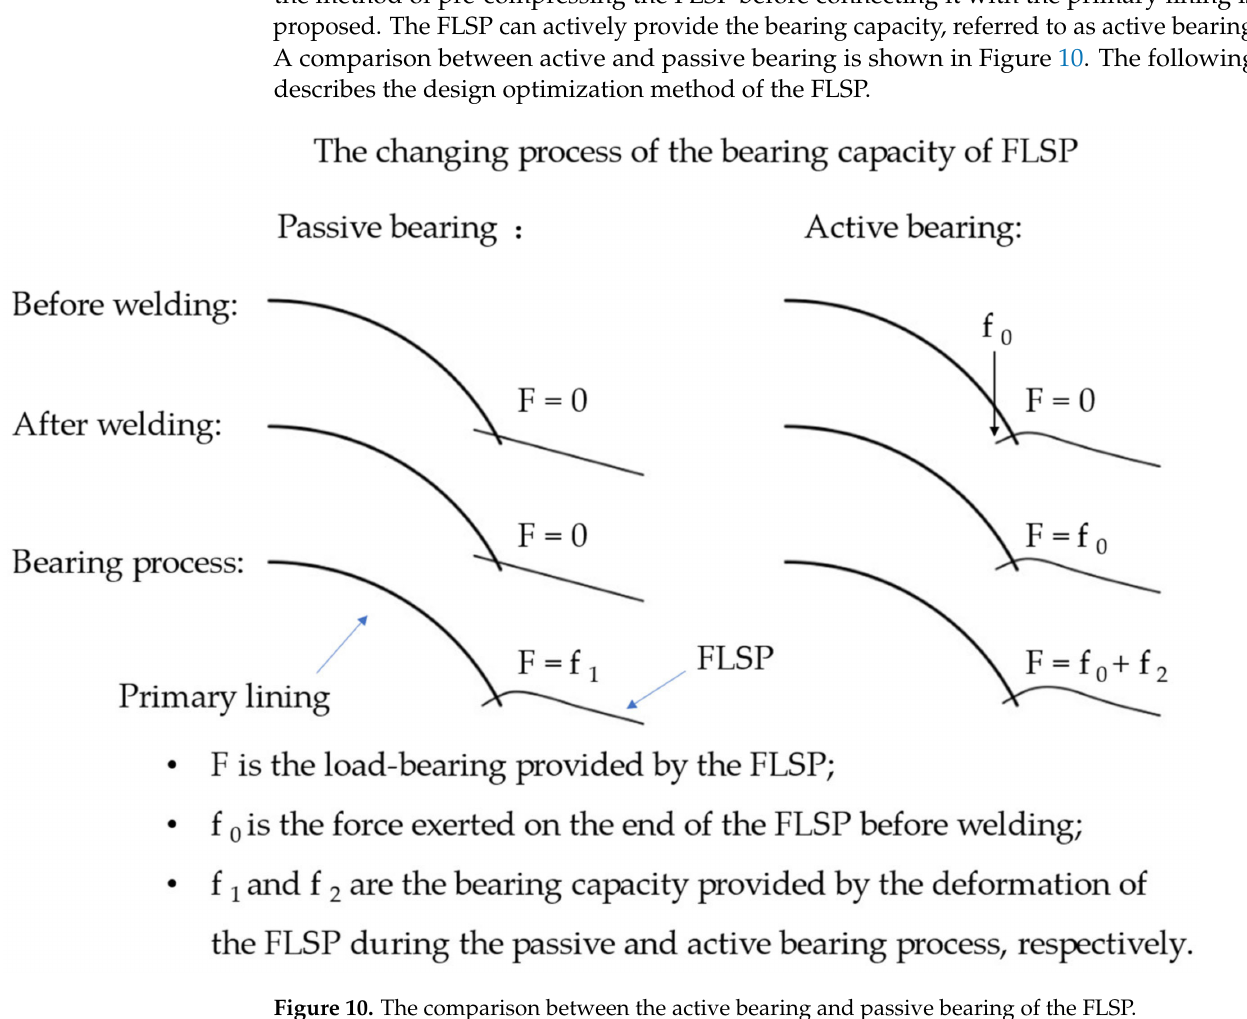
Figure 10. The comparison between the active bearing and passive bearing of the